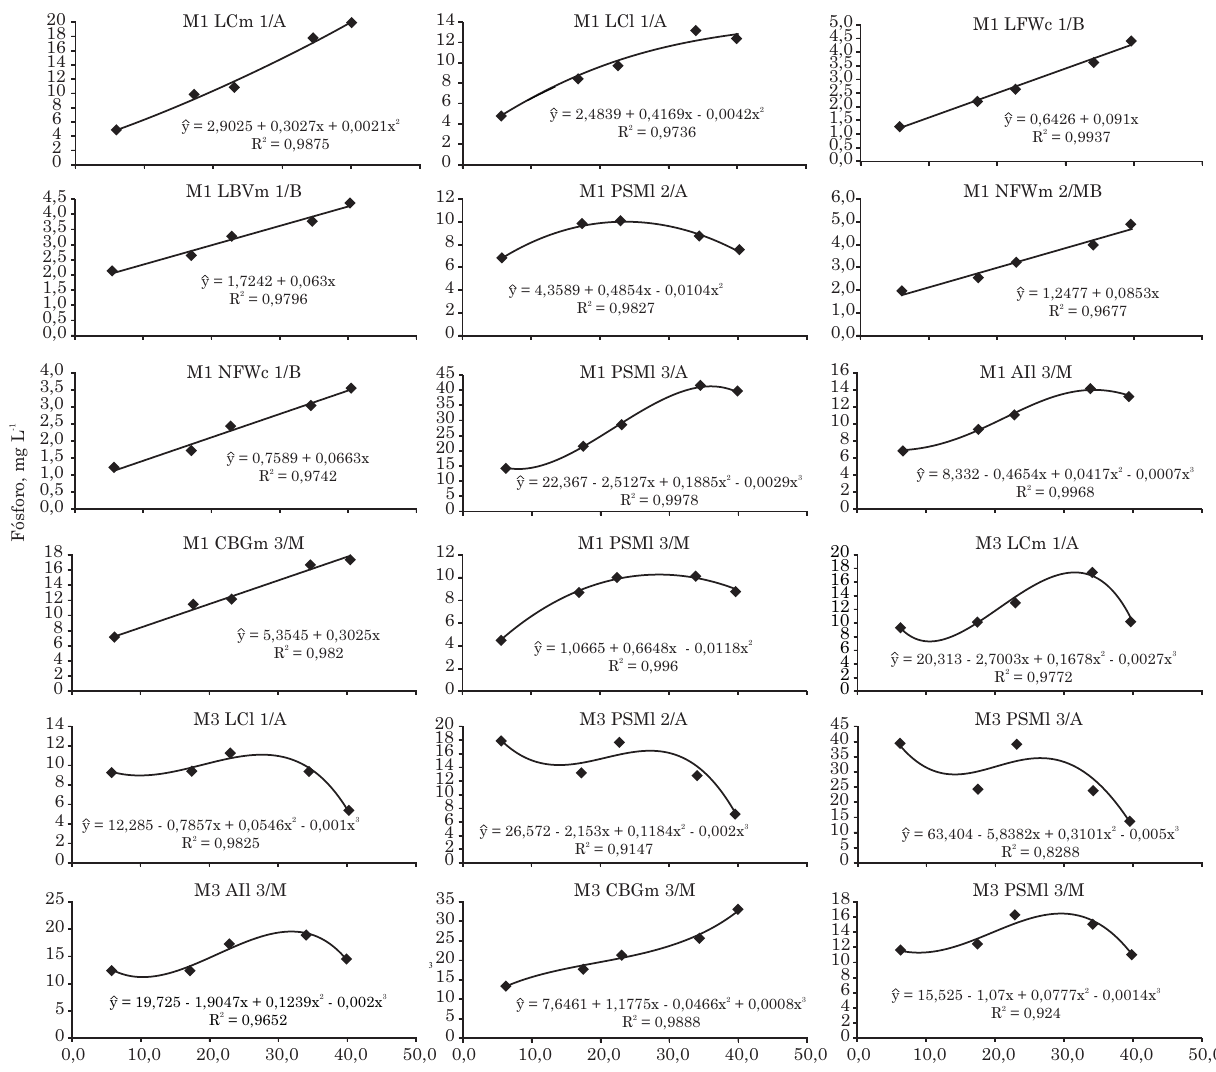
Figura 3. Regressão entre os teores de P extraído pelas soluções Mehlich-1 e Mehlich-3, em diferentes solos e o volume vazio do frasco (relação